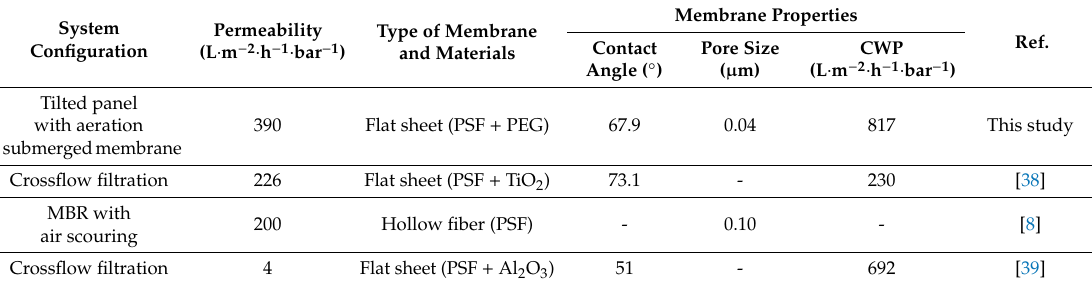
Table 2. Performance of PSF membranes with variable properties applied in membrane bioreactor (MBR) systems to treat activated sludge using di ff erent system